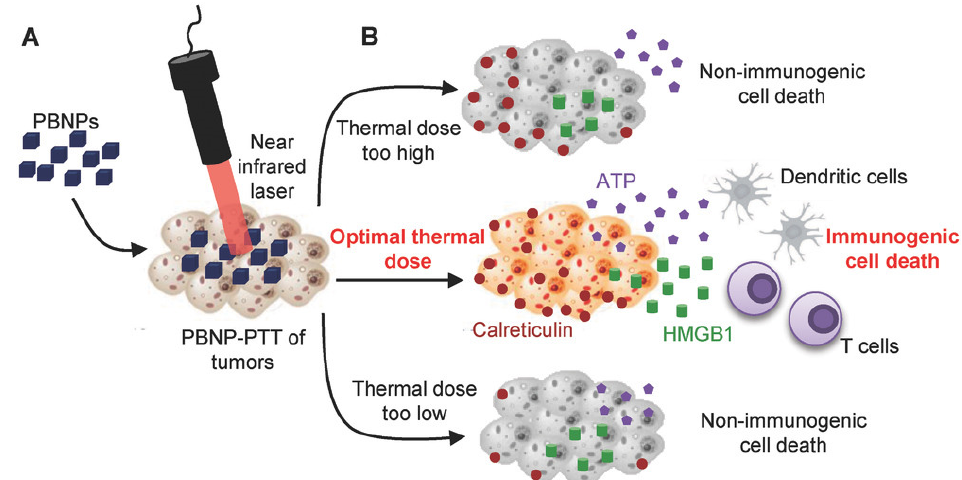
Figure 5. PTT-based thermal ablation of tumor cells, causing tumor cell death and inducing multiple immune responses at different temperatures. (A) NIR laser irradiated Prussian blue nanoparticles for photothermal therapy. (B) Role of thermal doses in cancer cell death. Optimal thermal dose promotes immunogenic cell death and immunotherapy. Reproduced from Sweeney et al. [64] which is licensed under a Creative Commons Attribution-(CC BY 4.0) International License (http://creativecommons.org/licenses/by/4.0/). Table 1. Role of MNPs in TME modulation.